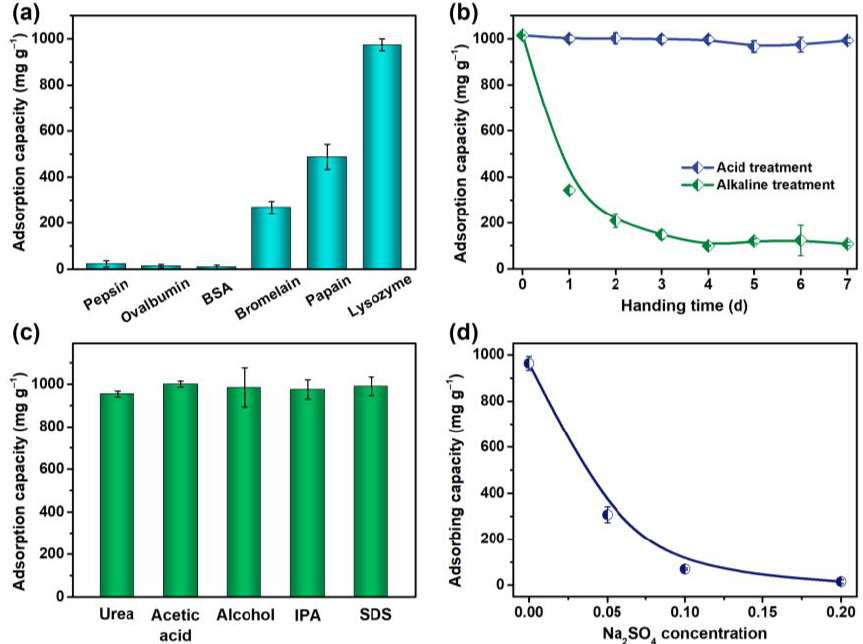
Figure 8. ( a ) Adsorption selectivity and ( b ) adsorption capacity of the NHMs after being exposed to acid (pH = 2) and alkali (pH = 10) buffer for different lengths of time. ( c ) Solvent resistance and ( d ) influence of ionic strength of the NHMs.